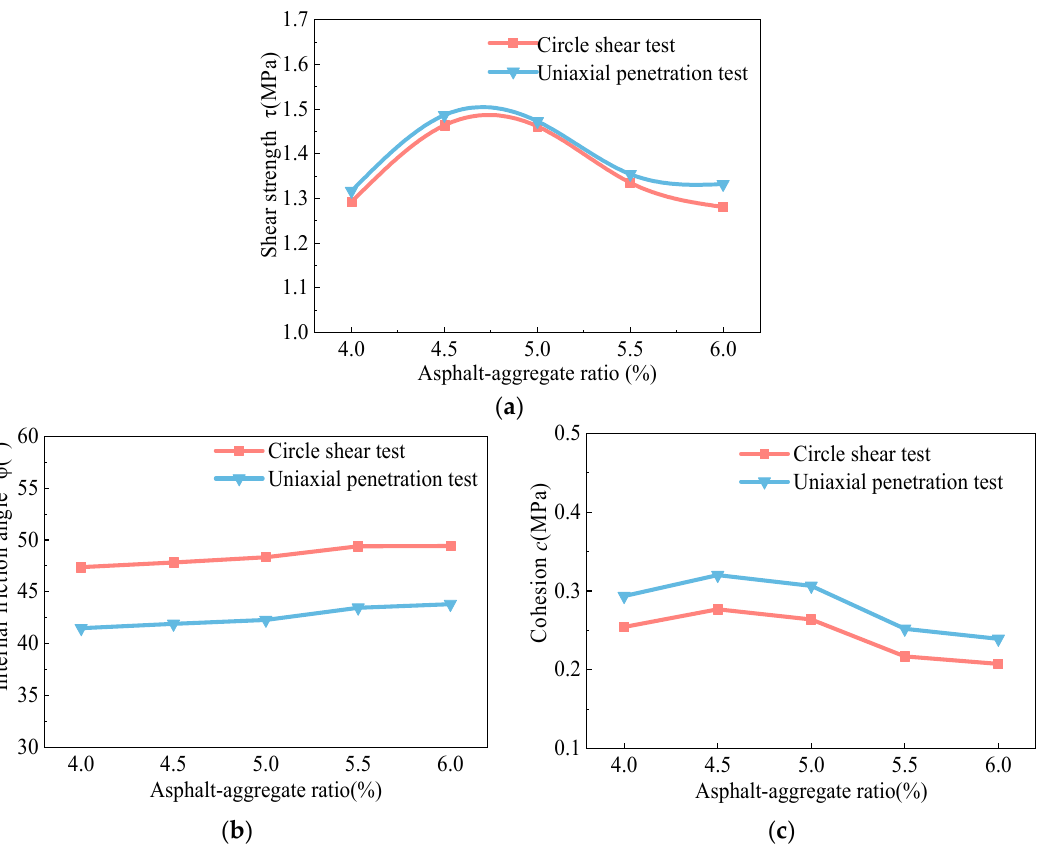
Figure 8. Shear strength, internal friction angles, and cohesion of different asphalt contents. ( a ) Shear strength; ( b ) Internal friction angle; ( c ) Cohesion.